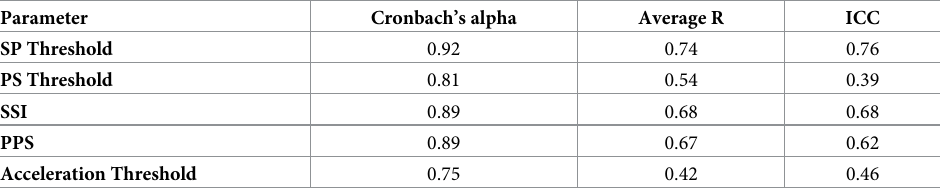
Table 1. Tau-equivalent reliability (Cronbach’s alpha) and intraclass correlation coefficient (ICC) for parameters measured on the swinging